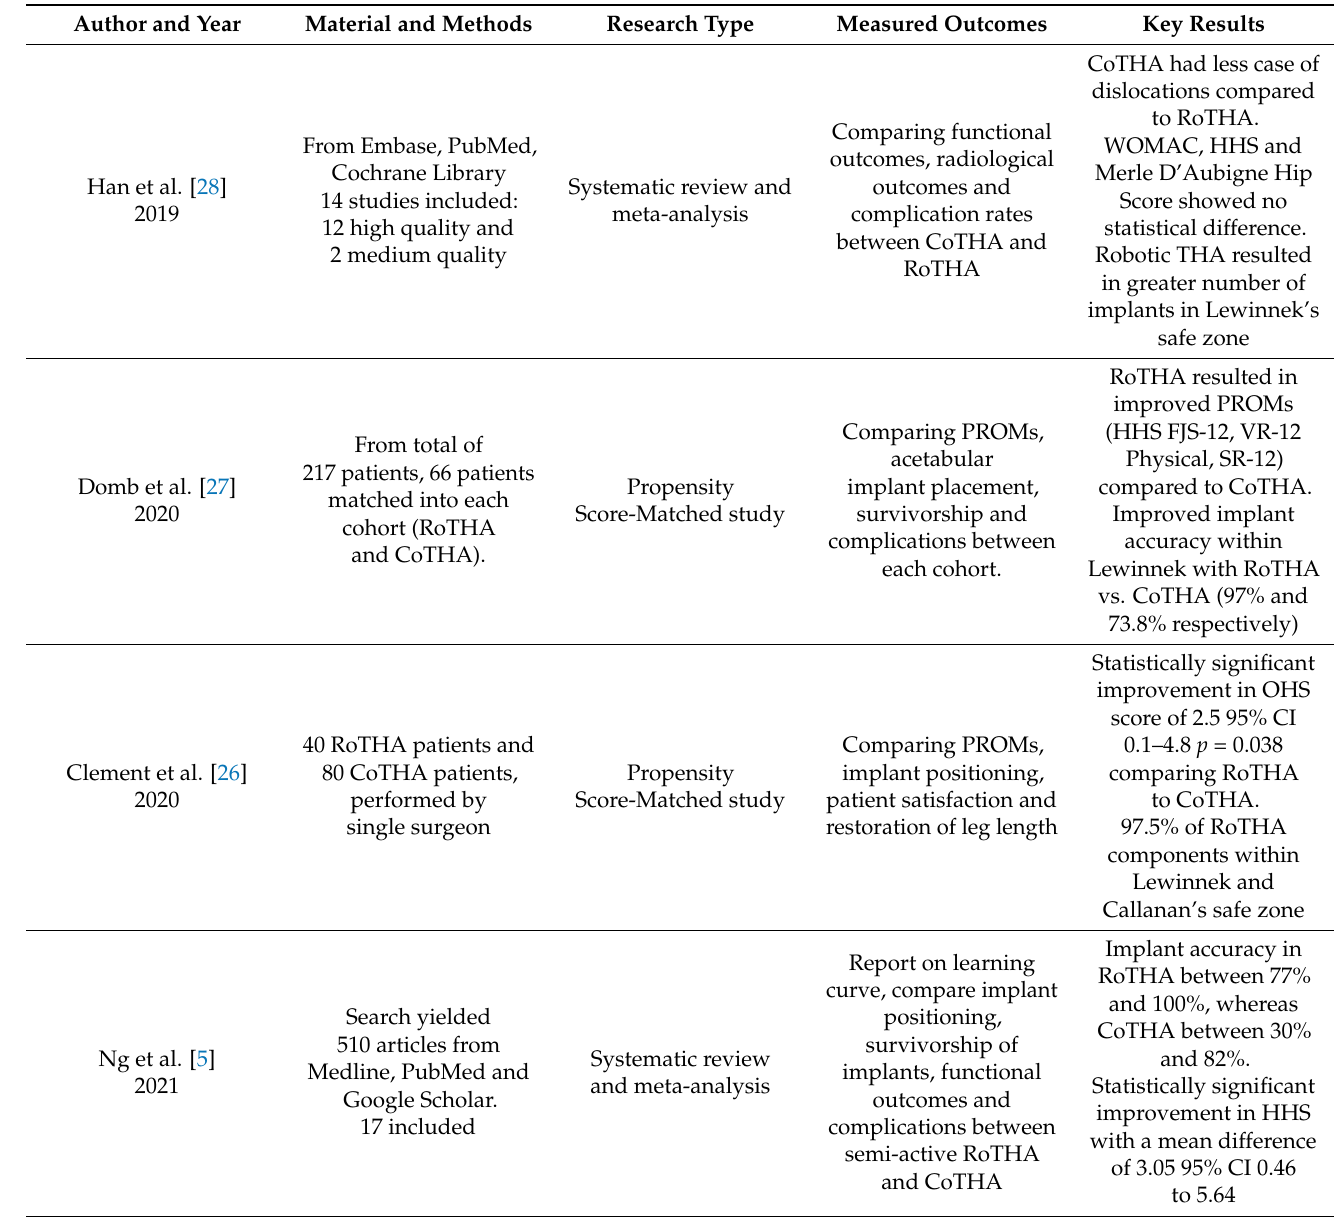
Table 1. Table of characteristics and results of the studies reporting outcomes comparing conventional and robotic total hip